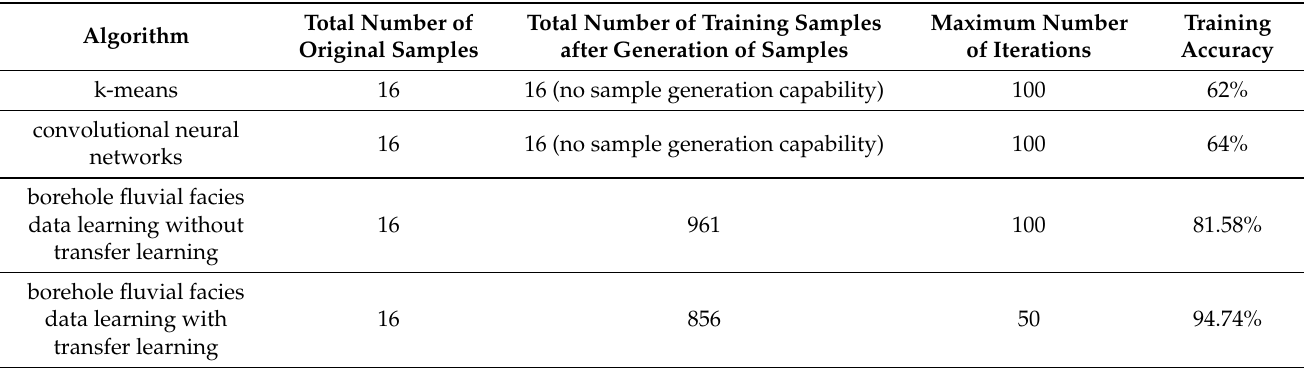
Table 1. Results of the identification algorithm of the genesis of the